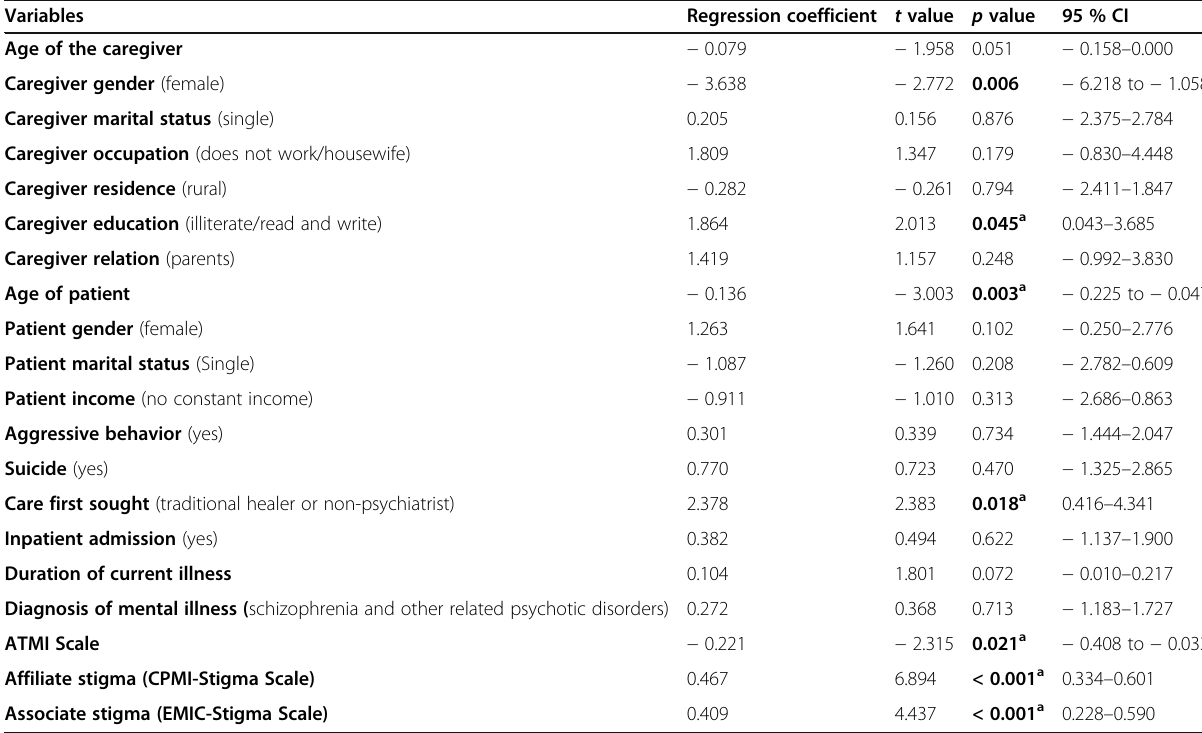
Table 6 Correlates of burden among the studied participants at Assiut University Hospital, Egypt, 2017